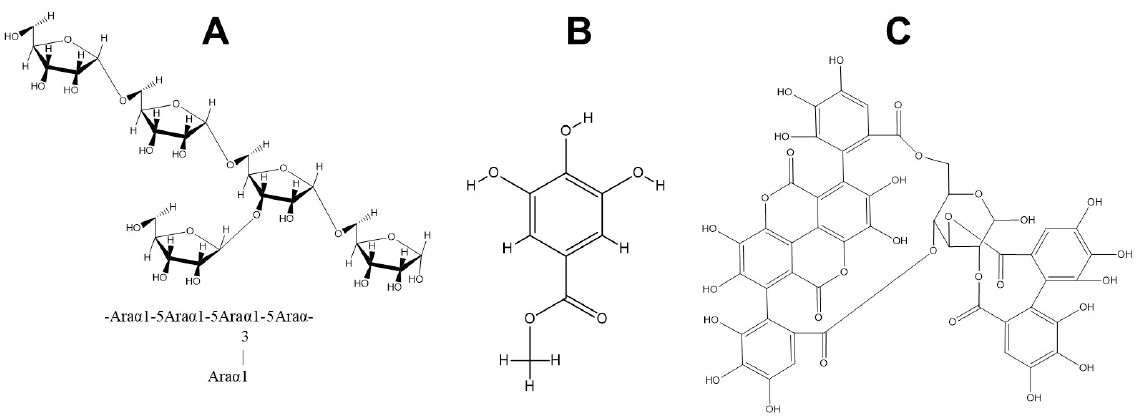
Figure 8. Structures of arabinan ( A ), methyl gallate ( B ), and punicalagin ( C ) used as substrates for the enzymatic